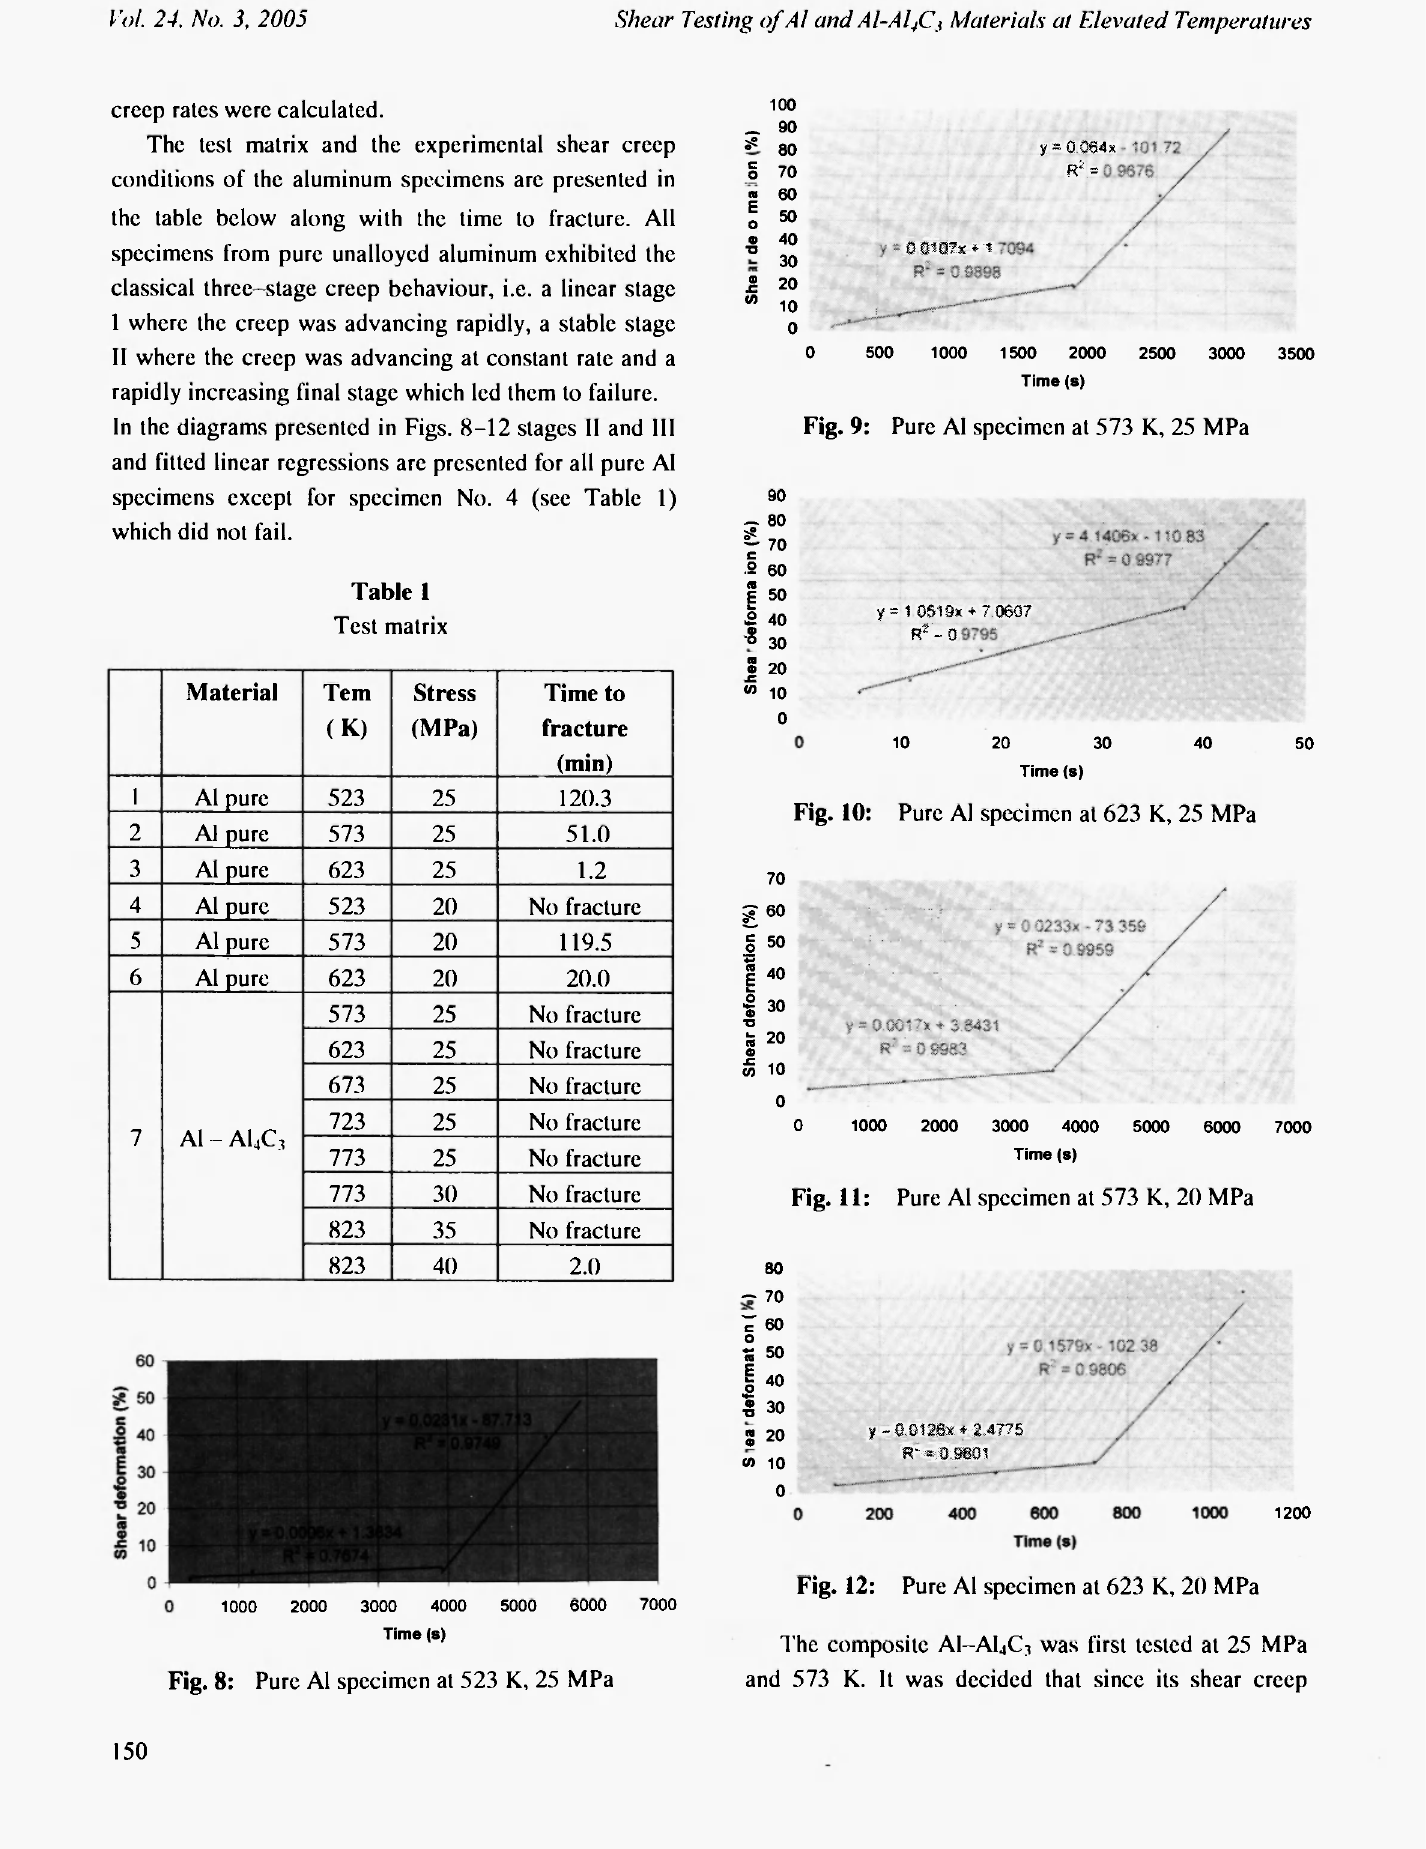
Fig. 8: Pure Al specimen at 523 K, 25 MPa